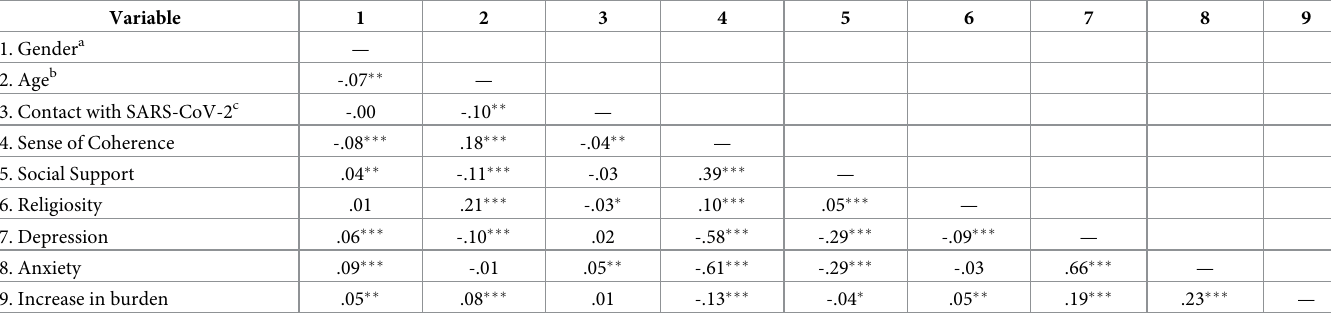
Table 3. Correlations for demographics, resources, mental health symptoms and increase in burden.